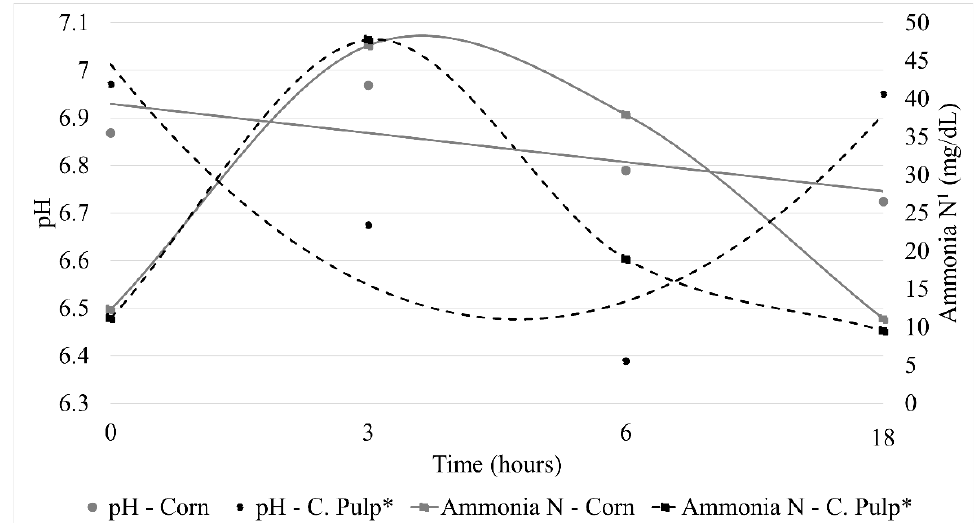
Figure 1. Rumen parameters at different sampling times (0, 3, 6 and 18 h) of rumen-cannulated Nellore steers continuously grazing Uruchloa brizantha cv Marandu pastures and fed corn or citrus pulp-based supplements during the wet-dry transition period; 1 Ammonia N: rumen ammonia nitrogen; C. Pulp* = citrus pulp.